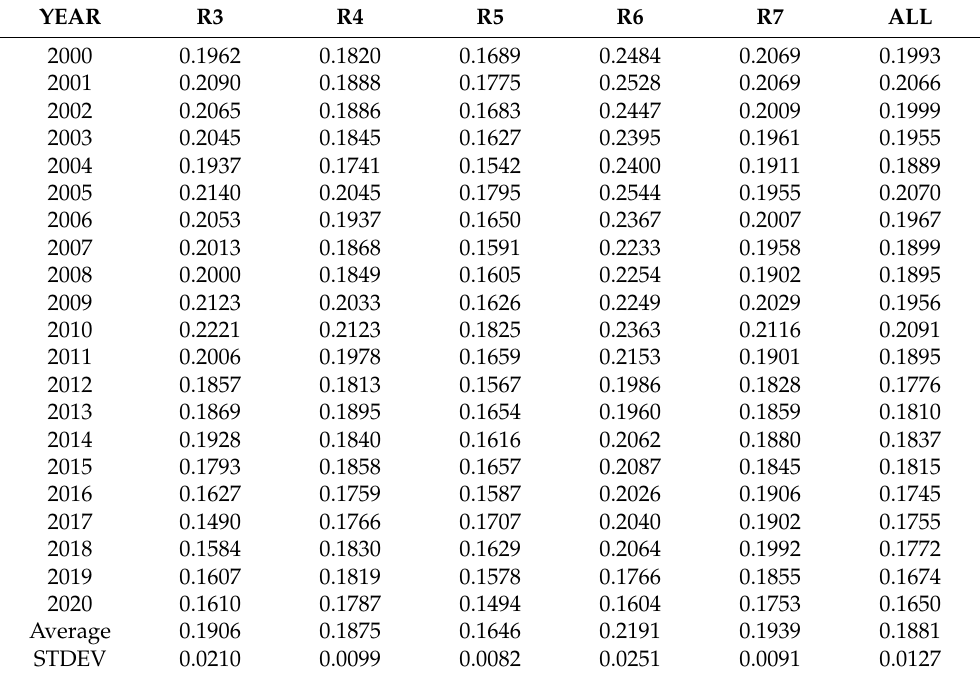
Table A1. Average peak growing season EVI2, the average and standard deviation from 2000 to 2020 for the Lower Colorado River.